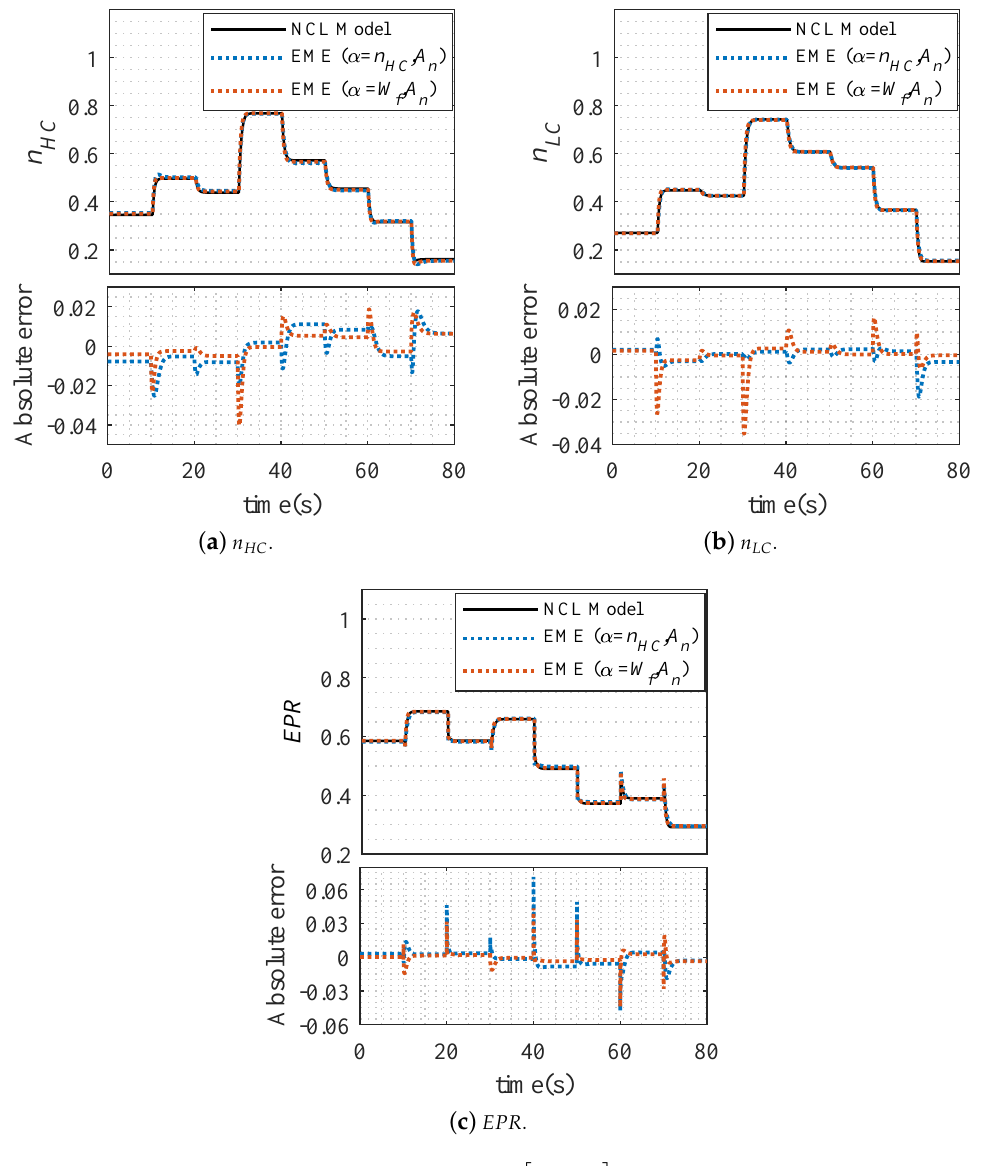
Figure 16. The validation of the EME ( α = [ n HC , A n ] , α =